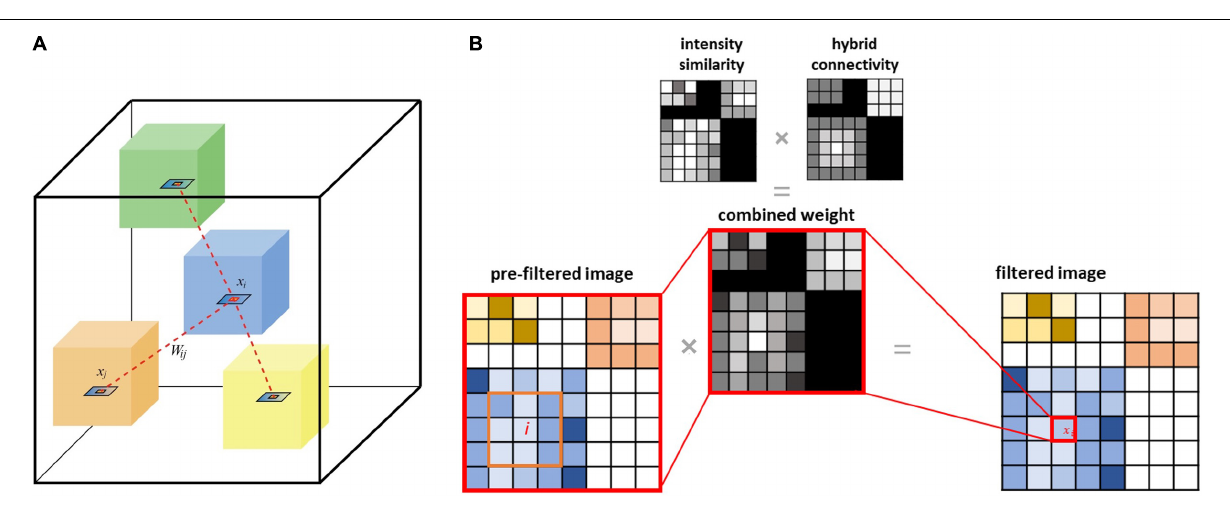
FIGURE 2 | (A) Schematic illustration of the proposed connectome-based NLM filter applied to voxel intensity x i (inside the blue cube), which incorporates connectivity (both local and distant) and intensity similarity information. Each coloured cube schematically represents a node of the brain parcellation; the dashed lines between the blue cube and other cubes represent the inter-nodal (distal) structural connectivity. (B) The filtered value for any given voxel i is computed as the weighted sum of values for every brain voxel. This weighting is based on voxel-wise PET intensity similarity and connectivity strengths between each pair of nodes in the parcellation (distant connectivity) and intra-node distance measurements (local